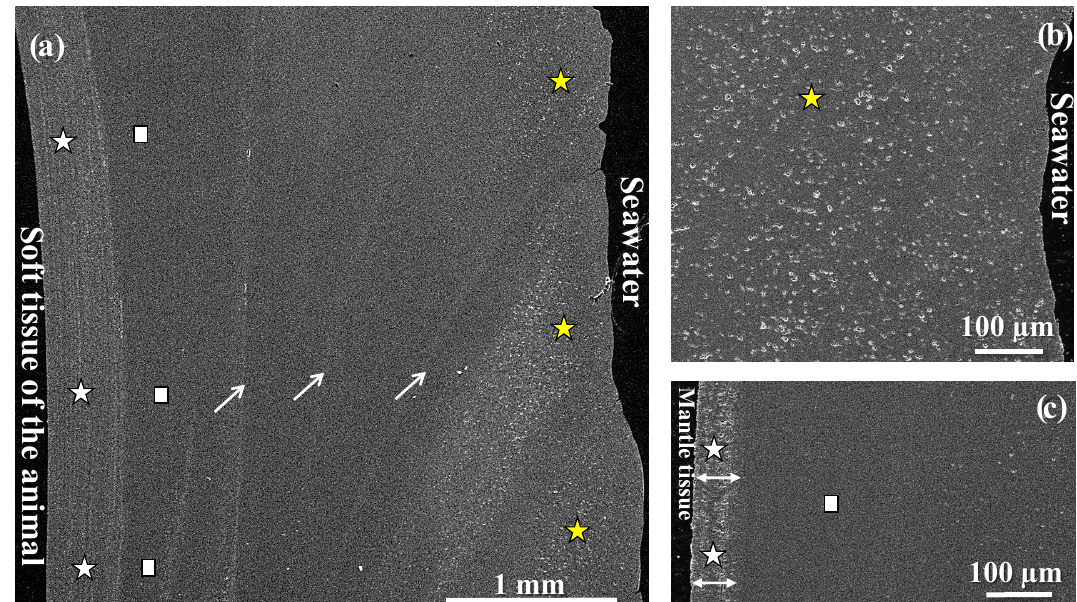
Figure 1. SEM image showing ultrastructure characteristics of the shell of modern Arctica islandica (a) , its high porosity in shell layers facing seawater (yellow stars in a , b ) and the denser shell portions (white stars in a , c ) close to the soft tissue of the animal. The innermost shell portions contain elongated pores (white stars in c ) with the long axis of the pores oriented perpendicular to the inner surface of the shell (white arrows in c ). Highly dense shell parts are also present (white rectangles in a , c ), in which pore density and size is very low and where minute aragonite crystals are closely packed. White arrows in (a) indicate the location of growth